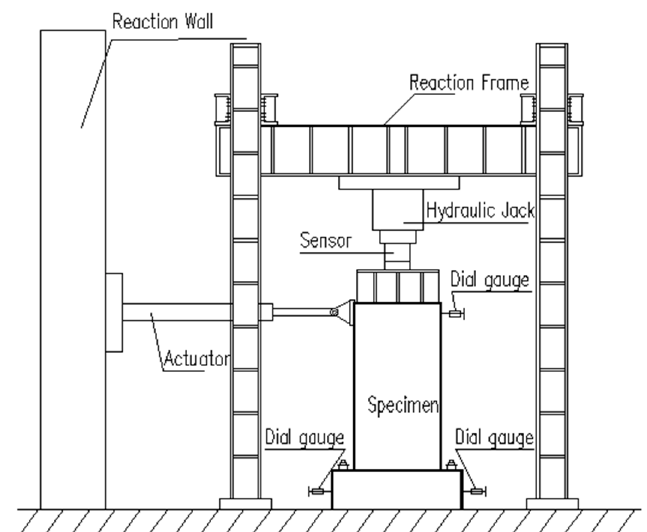
Figure 5. Layout of test loading.